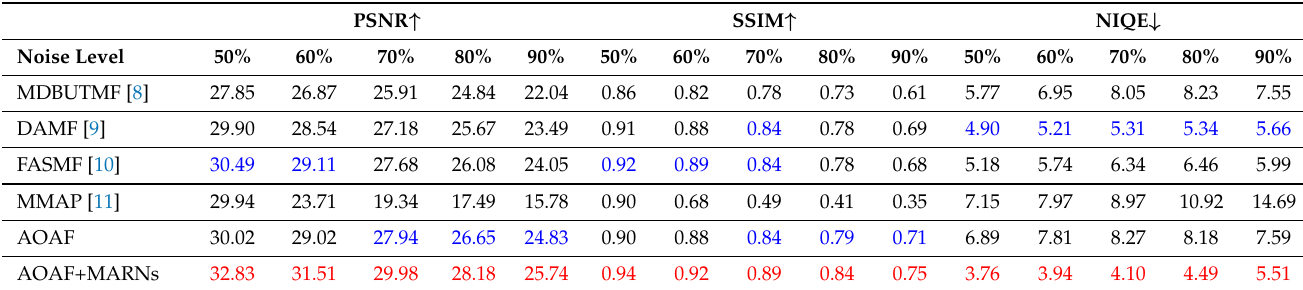
Table 1. Objective quality comparisons of all the compared methods. All the scores are averaged over the test dataset. The best score in each column is marked in red and the second-best in blue.